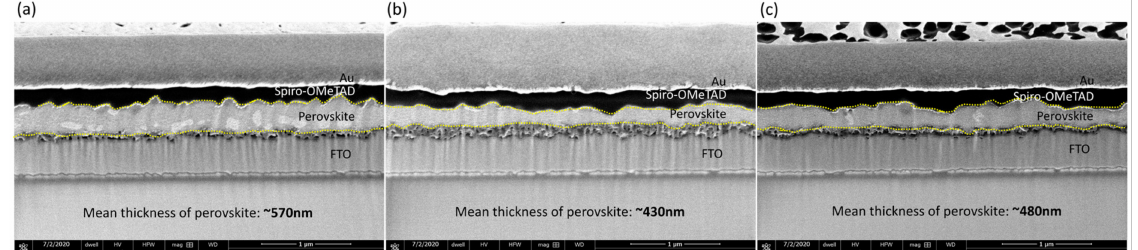
Figure 6. The cross-sectional SEM of full devices of ( a ) PSM_PbI 2 and ( b ) 1.5 M ( c ) 1.6 M PSM_Pb(NO 3 ) 2 two-step dipping